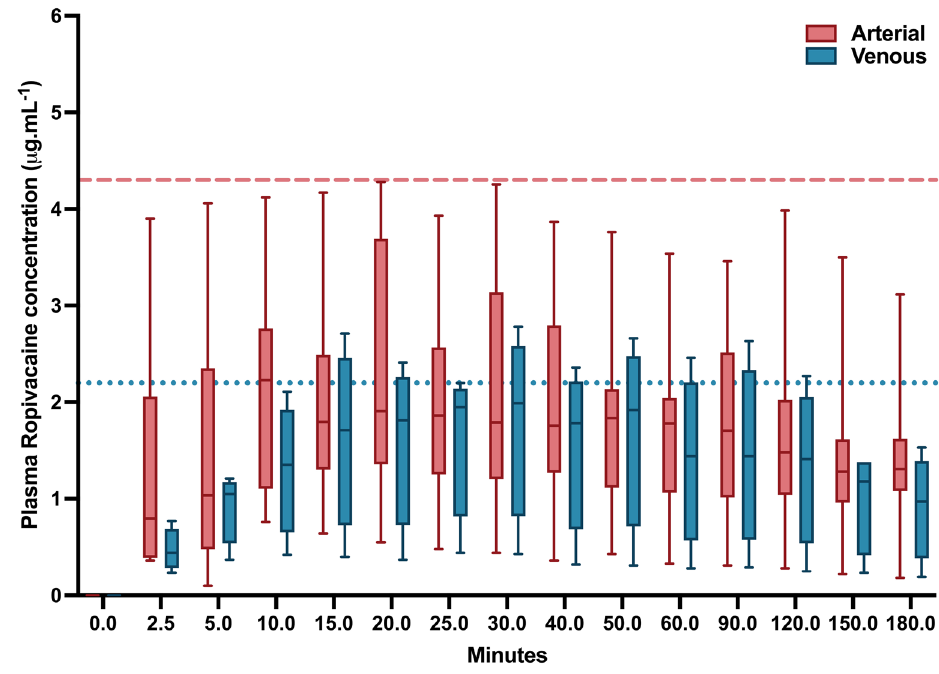
Figure 2. Total ropivacaine plasma arterial and venous concentrations. Data are presented as box and whisker plots with the line within the box indicating the median, the box representing the 25% and 75% percentiles, the whiskers indicating the 5% and 95% percentiles, and the single spots representing the extremes. Red dotted line = 4.3 μg/ml, blue dotted line = 2.2 μg/ml; In Knudsen study the mean tolerated arterial and venous